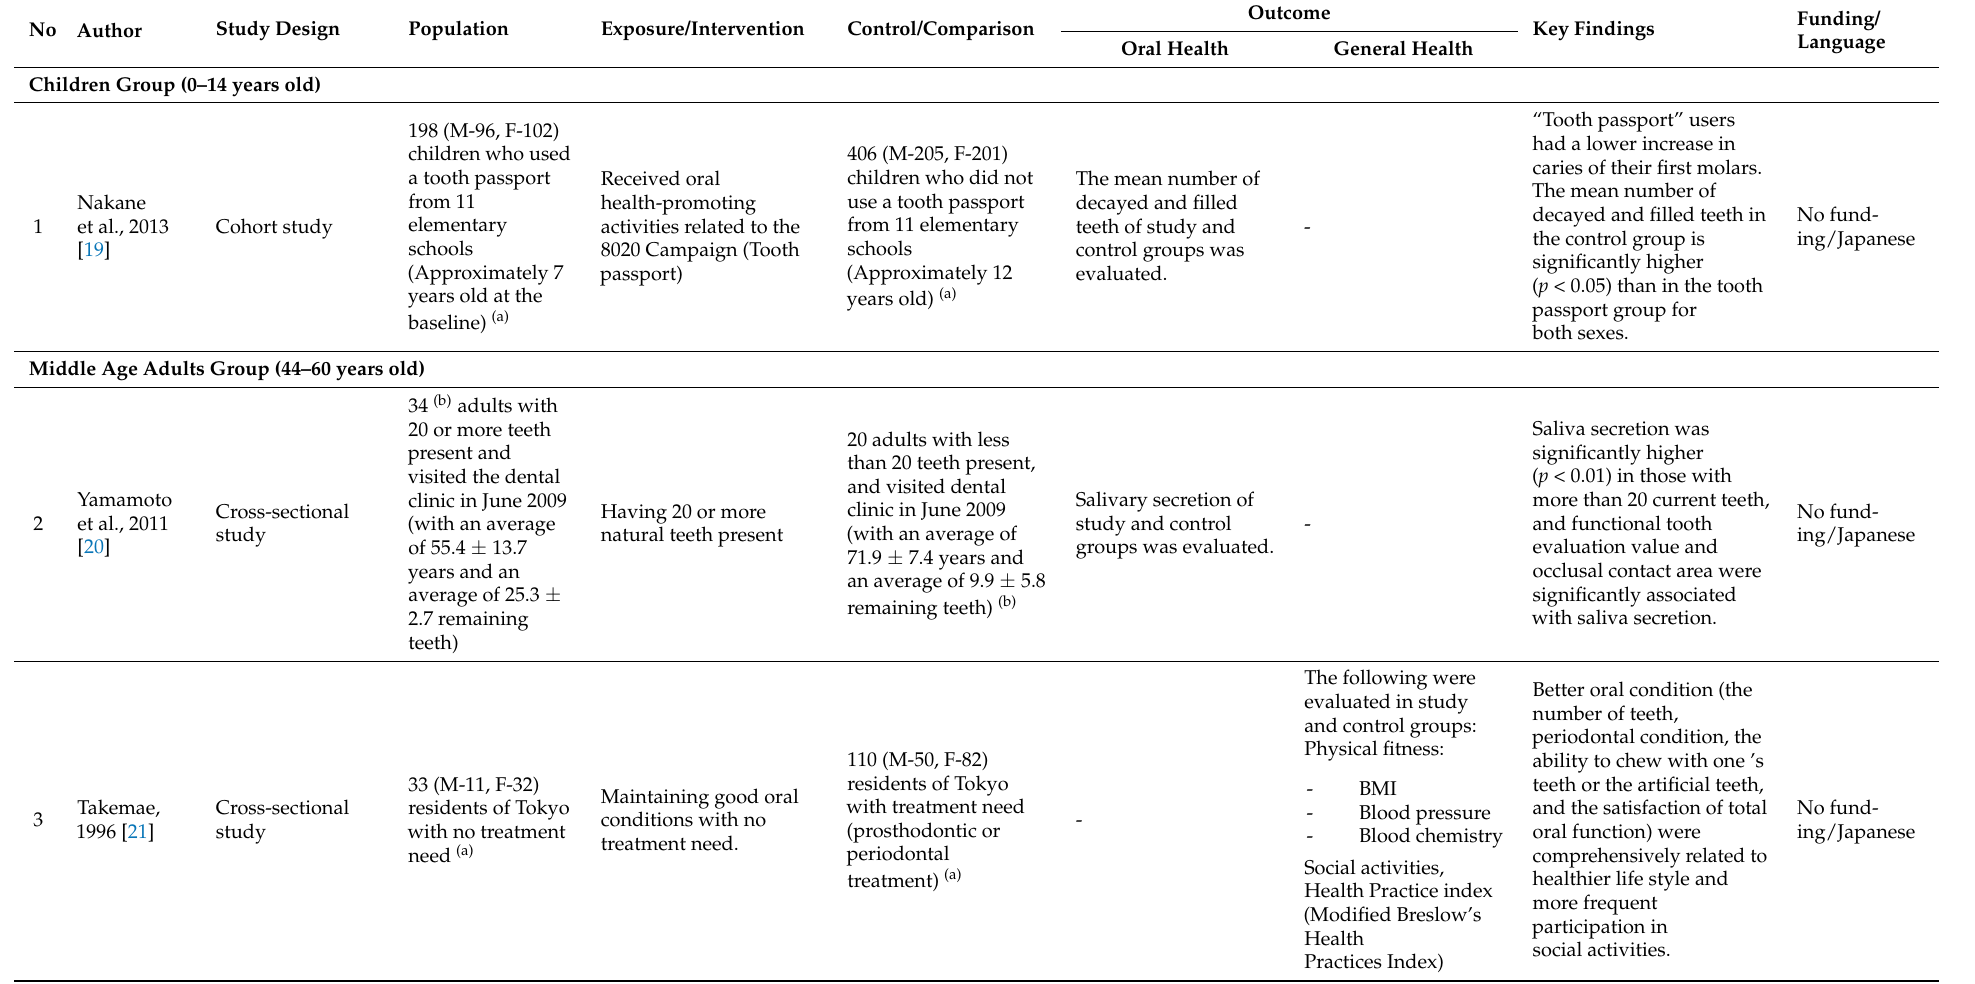
Table 2. The outcomes of the 8020 Campaign from the included